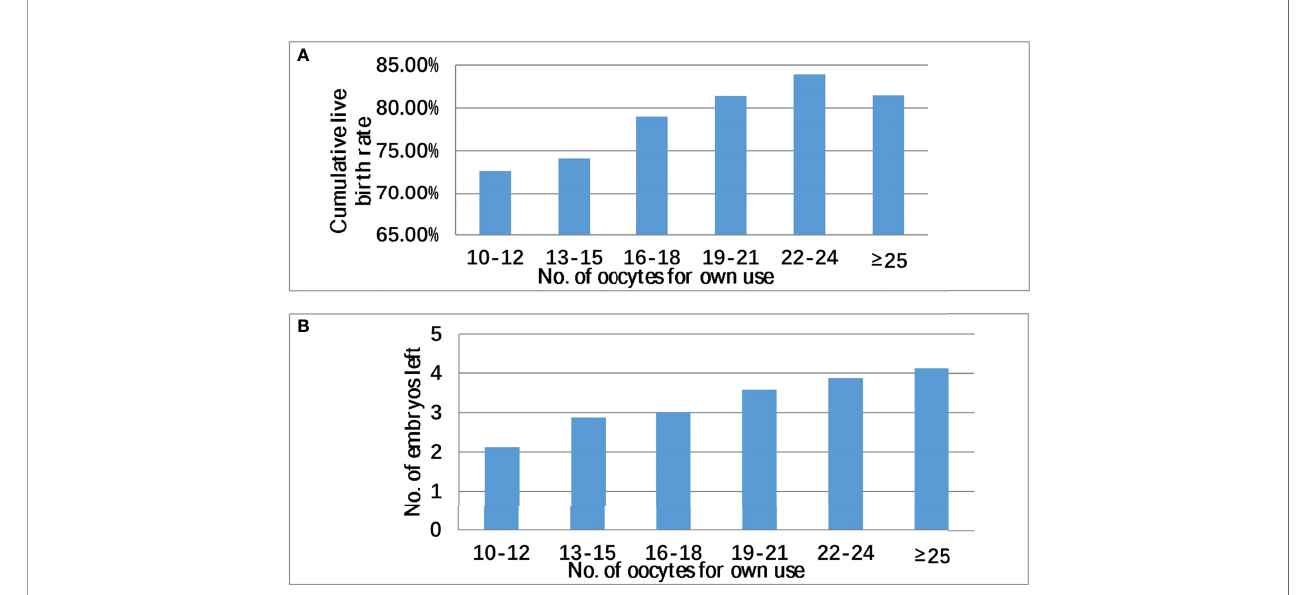
FIGURE 2 | Cumulative live birth rate (A) , supernumerary embryo (B) , and number of oocytes retrieved in all patients with oocyte ≥